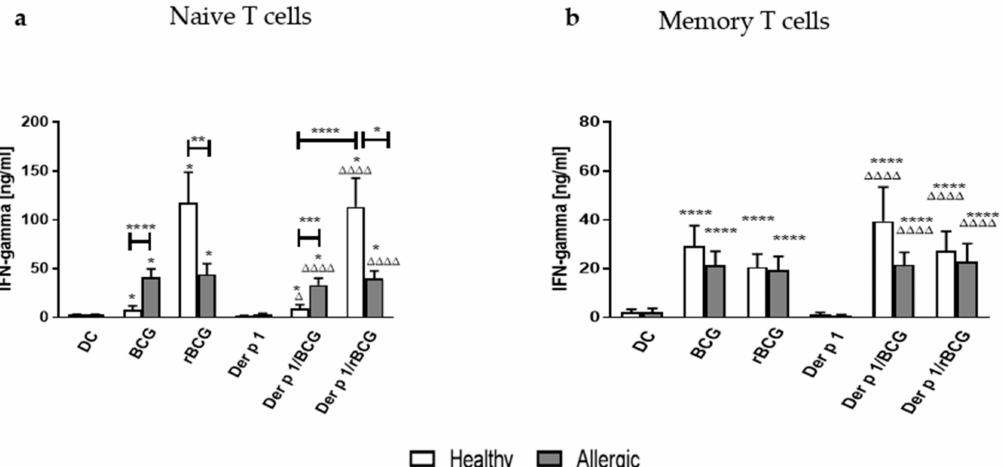
Figure 3. Secretion of IFN- γ by human naive T cells ( a ) and memory T cells ( b ) following 96 h coculture with BCG- (1:1), rBCG-hIL-18 (rBCG)- (1:1), Der p 1- (1 µ g/mL), Der p 1/BCG- or Der p 1/rBCG-pulsed autologous MD-DCs (ratio MD-DCs/T cells, 1:10). The cytokine levels in the cocultures were measured in duplicate by ELISA. Data shown are the medians ± SEM for 22 allergic patients and 40 healthy donors. Statistical analyses were performed by using the Kruskal– Wallis test for unpaired data. * p < 0.05; ** p < 0.01; *** p < 0.001; **** p < 0.0001 versus control (unstimulated DC), unless indicated by the horizontal bars; ∆ p < 0.05; ∆∆∆∆ p < 0.0001 versus Der p 1.